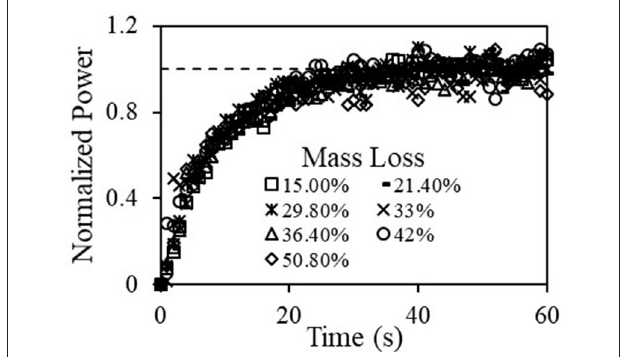
FIGURE 4 | Experimental and modeled mass loss transients for the un-densified material and the pellets, using Equation (11), the temperature transients of Figure 3 and fitting for T a and A † .